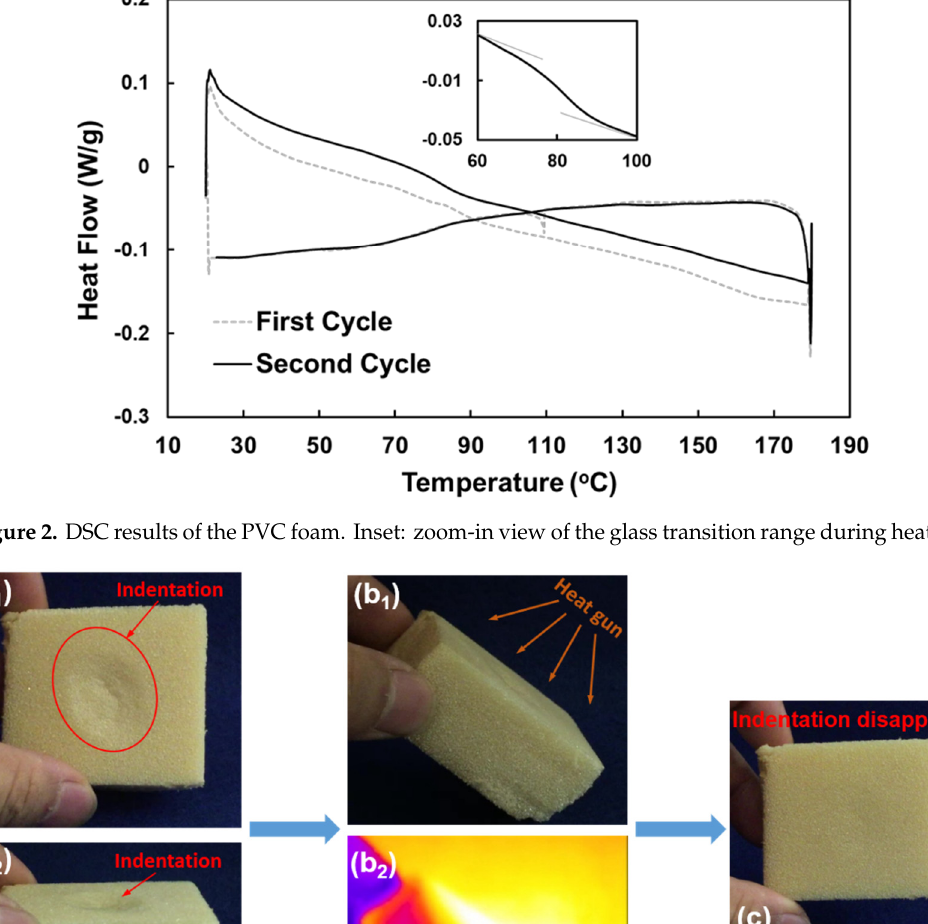
Figure 2. DSC results of the PVC foam. Inset: zoom-in view of the glass transition range during heating.